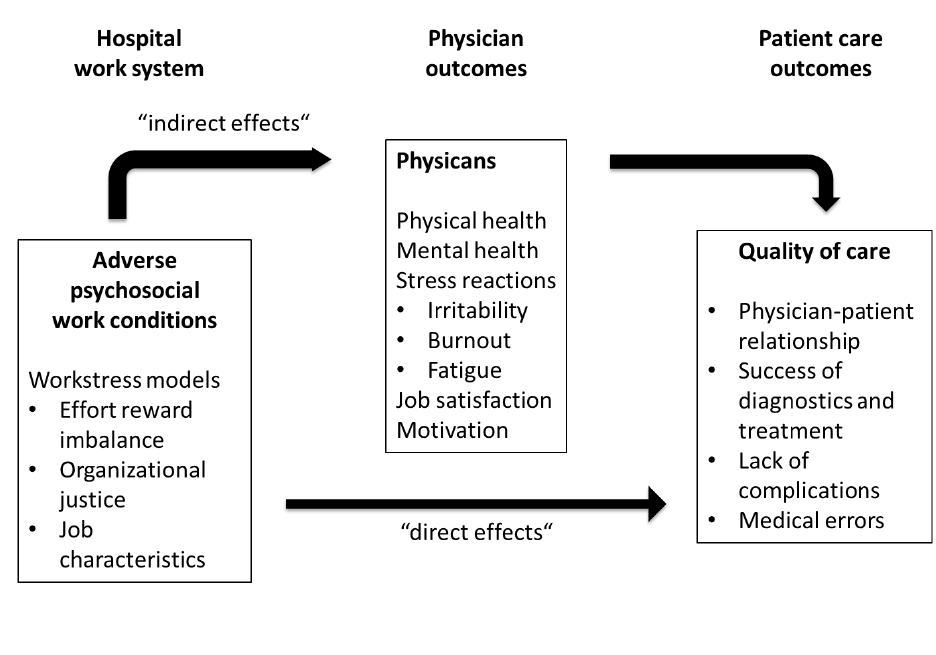
Framework on indirect and direct pathways of physicians’ psychosocial work con- ditions and well-being for the quality of